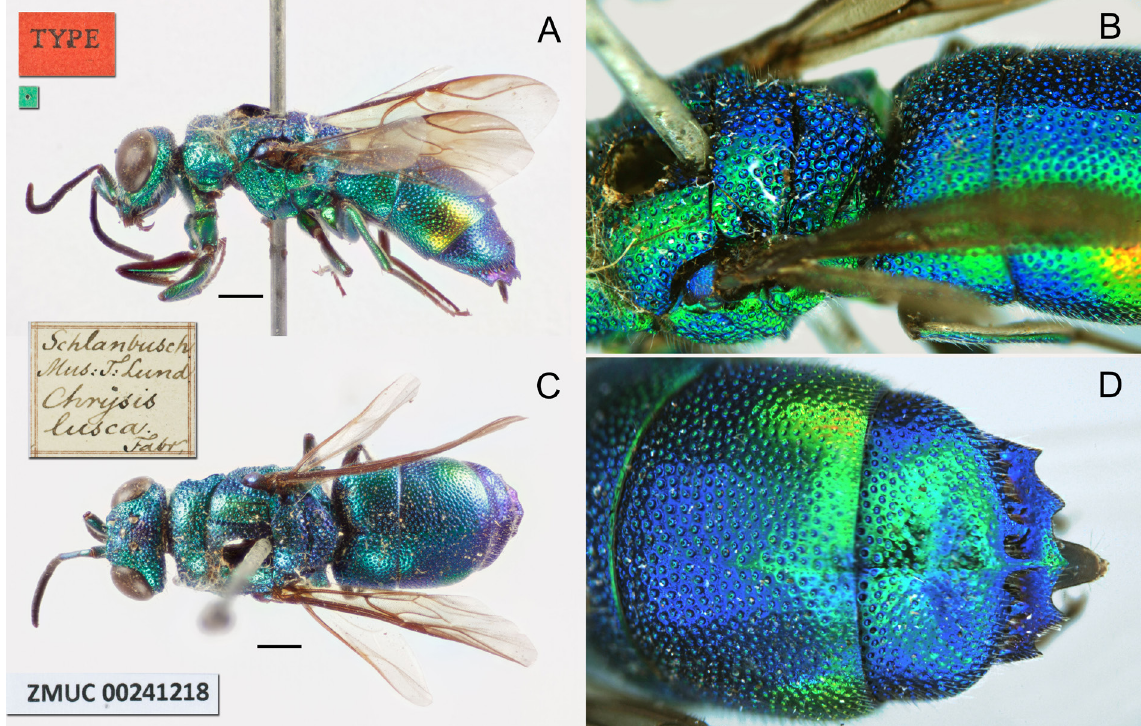
Fig. 4. Trichrysis lusca (Fabricius, 1804), ♀, holotype (HNHM). A . Habitus, lateral view. B . Mesosoma and T1, dorso lateral view. C . Habitus, dorsal view. D . Metasoma, posterior view. Scale bars: 1.0